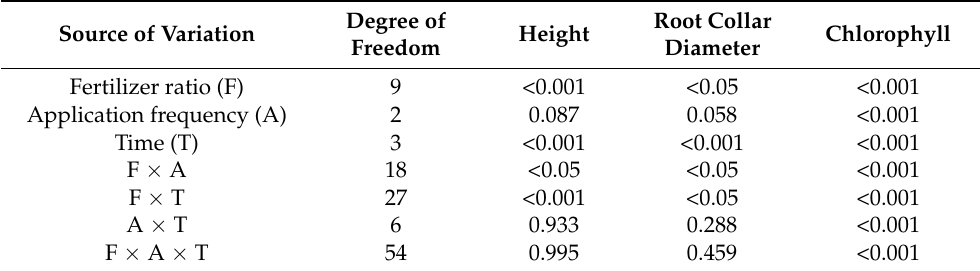
Table 3. The p values of the main effects of Fertilizer ratio (F), Application frequency (A), Time (T) and their interactions on seedling height, root collar diameter, and chlorophyll of M. wufengensis (Magnoliaceae) seedlings.